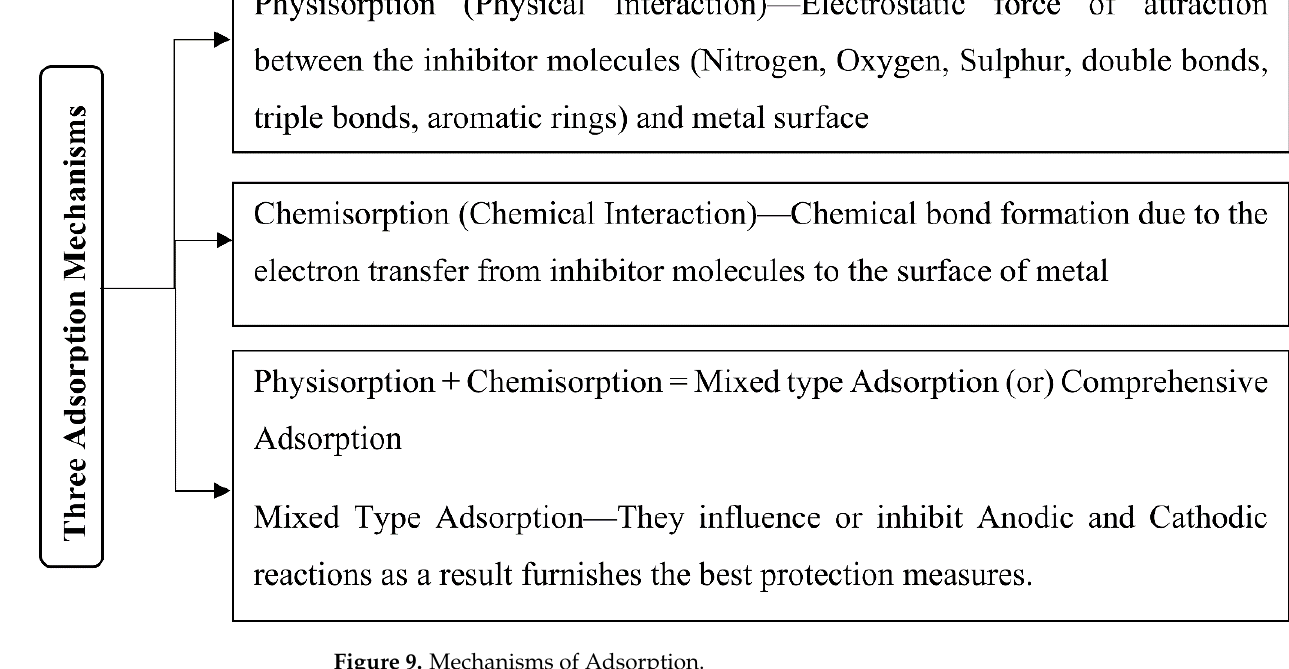
Figure 10. Concise overview of green corrosion inhibitors in RCC.